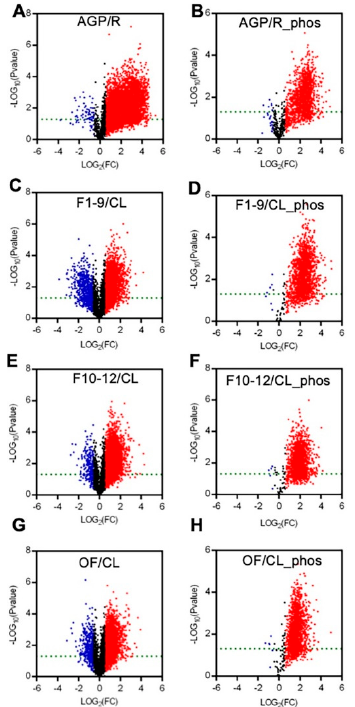
Figure 3. Summary of the expression levels of differences between AGP and R, F1–9 and CL, F10–12 and CL, OF and CL in quantitative peptides and phosphopeptides. ( A ) Volcano plot between R and AGP peptide samples. ( B ) Volcano plot between R and AGP phosphopeptide samples. ( C ) Volcano plot between F1–9 and CL peptide samples. ( D ) Volcano plot between F1–9 and CL phosphopeptide samples. ( E ) Volcano plot between F10–12 and CL peptide samples. ( F ) Volcano plot between F10–12 and CL phosphopeptide samples. ( G ) Volcano plot between OF and CL phosphopeptide samples. ( H ) Volcano plot between OF and CL phosphopeptide samples. R, 14-day-old root; AGP, 14-day-old tissues above ground part; CL, cauline leaves; F1–9, stage 1–9 flowers; F10–12, stage 10–12 flowers; OF, opened flowers. The red denotes log2FC > 1 and p -value < 0.05. The blue denotes log2FC < − 1 and p -value < 0.05. The black denotes − 1 < log2FC < 1 or p -value > 0.05.